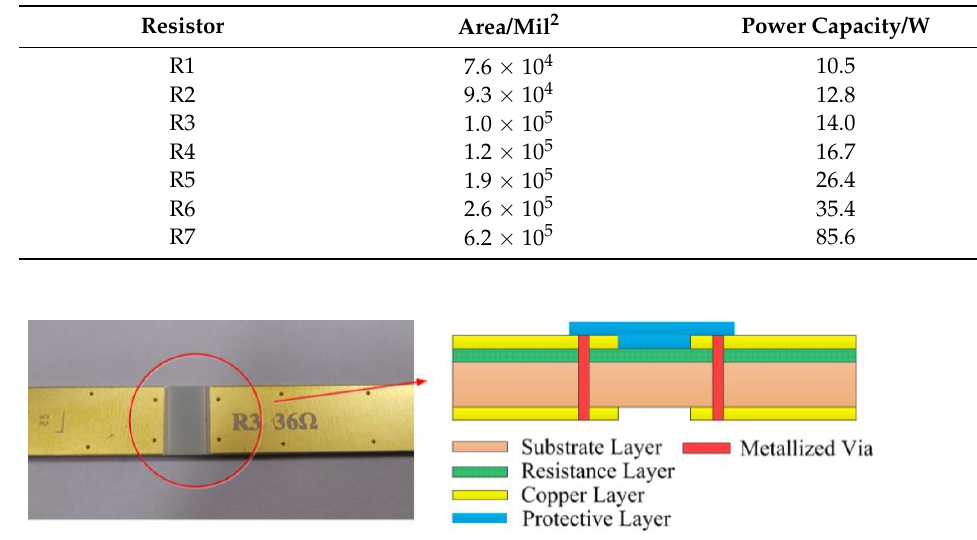
Table 1. Power capacity of each embedded resistor.